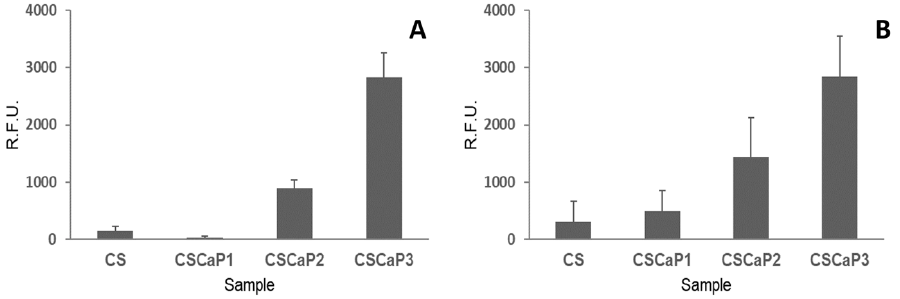
Figure 6. Metabolic activity (Alamar Blue) of cell cultures over CSCaP composites and control (CS monolith). ( A ) Premyoblastic C2C12GFP cell culture at 7 days and ( B ) osteoblastic MC3T3 cell culture at 7 days. R.F.U: Relative Fluorescent Units. N = 3.